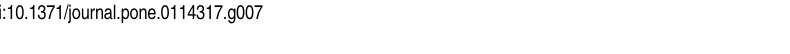
Figure 7. Performance comparison in combination with RF when r e 5